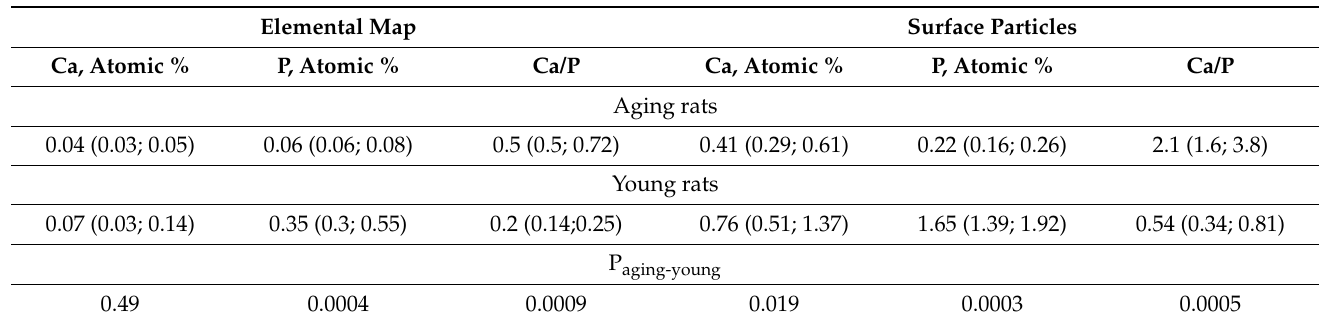
Table 1. Atomic Ca and P percentage, and Ca/P ratios in the subcutaneous fascia of young and adult rats. Data are presented as Me